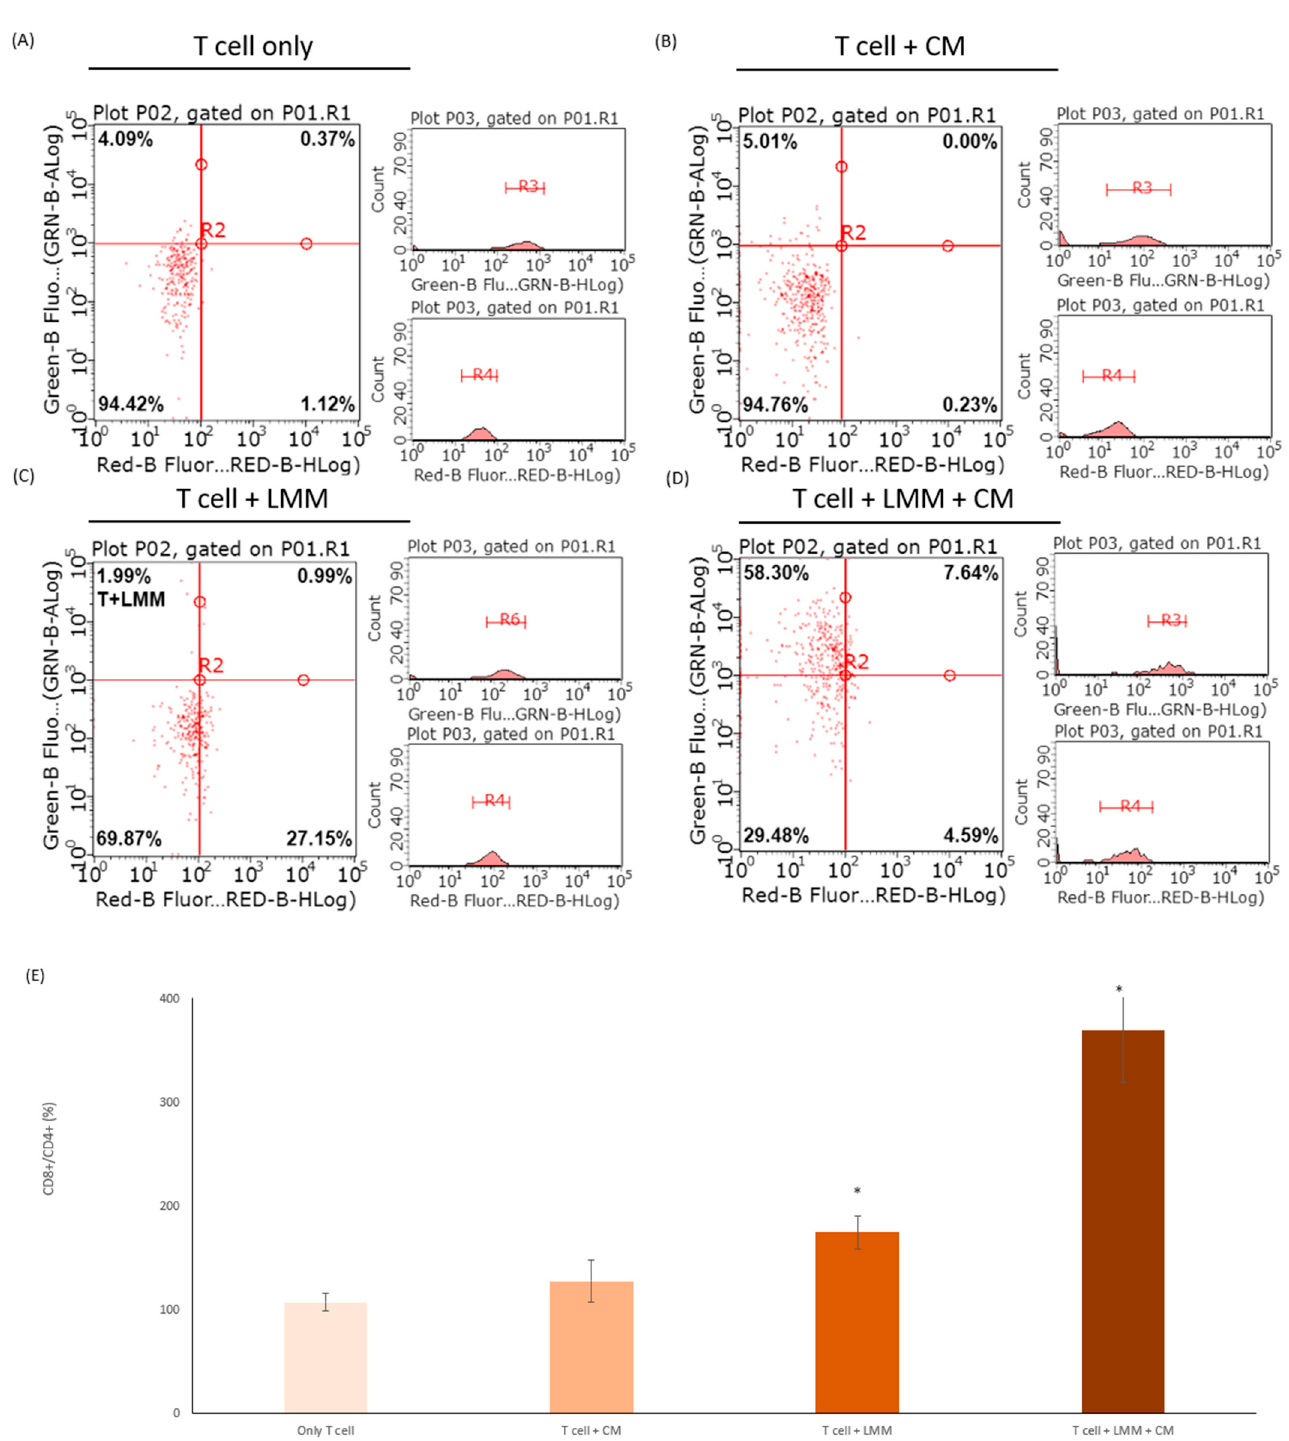
Figure 5. The cells with CD8+ and CD4+ cell markers were measured in ( A ) T cells, ( B ) T cells incubated with CM, ( C ) T cells cultured with LMM, and ( D ) T cells co-incubated with LMM and CM by flow cytometry. ( E ) The histogram of the ratio of CD8+/CD4+ in the four experiment groups above. * p <